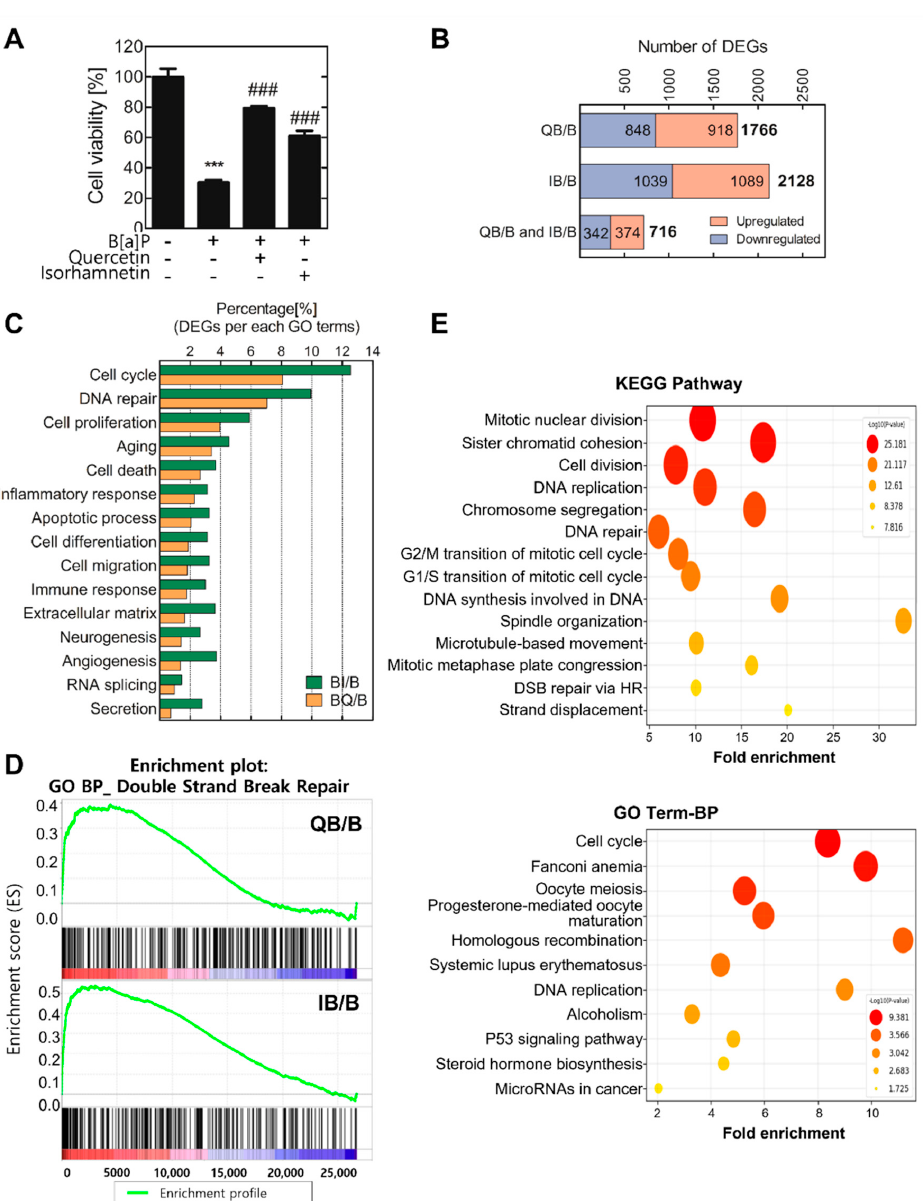
Figure 1. Quercetin and isorhamnetin each modulated expression of genes involved in DNA repair and homologous recombination. ( A ) The viability of cells co − treated with B[a]P and quercetin or isorhamnetin. ( B ) Total cellular RNA was extracted and used for microarray analysis. Differential gene expression analysis was performed by comparing the mRNA levels in B[a]P − treated cells with the levels in cells co − treated with B[a]P − treated and quercetin or isorhamnetin. ( C ) Gene ontology (GO) analysis was conducted using the 716 differentially expressed genes (DEGs, ≥ 1.5 folds). ( D ) Enrichment analysis was conducted on the DEGs ( ≥ 1.5 folds). The significantly affected pathways or GO terms are listed along the y-axes. The x-axes represent fold enrichment. The pathways or terms with a p -value < 0.05 were considered significantly enriched. ( E ) Gene set enrichment analysis plot shows that the DEGs are significantly enriched in DNA double-strand break repair. *** p < 0.001 compared with the control; ### p < 0.001 compared with B[a]P − treated cells. Q; quercetin, I; isorhamnetin, B; B[a]P.